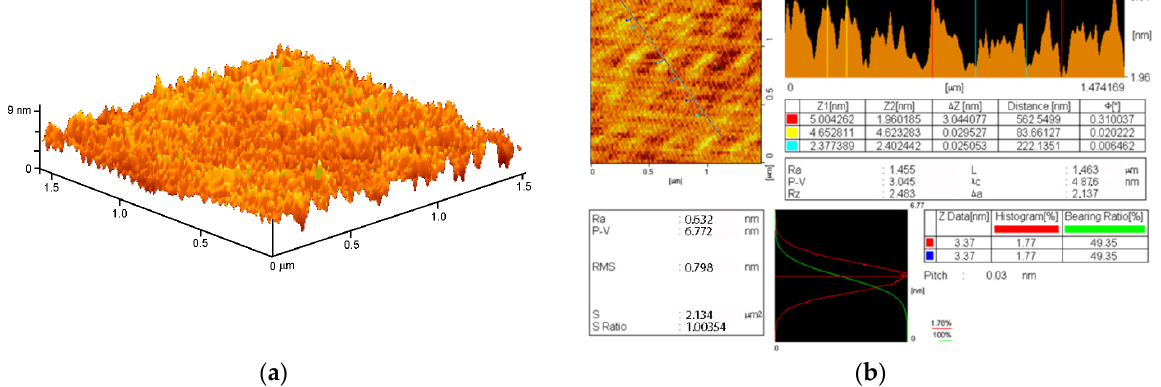
Figure 5. Reconstruction of the surface of a polymer and composites based on it, performed using an atomic force microscope. ( a ) 3D reconstruction; ( b ) surface analysis results.